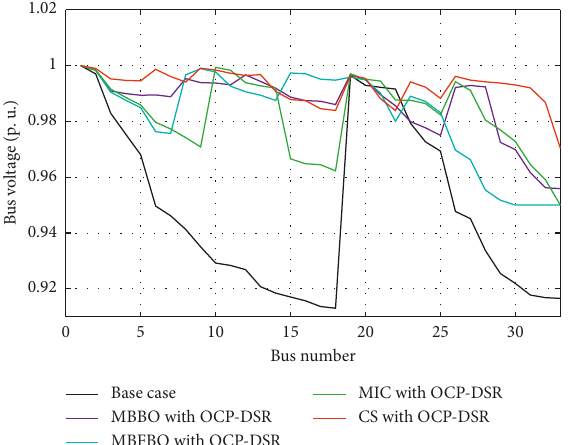
Figure 4: Voltage profile for 33-bus RDS using OCP-DSR